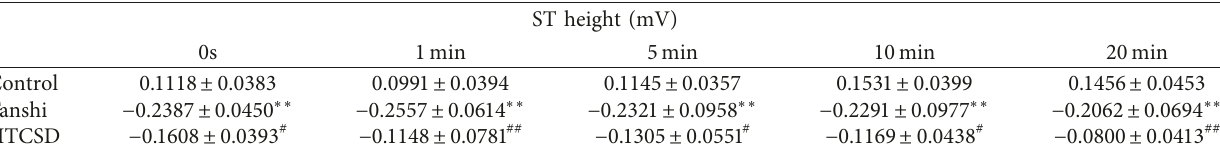
Figure 1: Electrocardiography and echocardiography. (a) ECGs of limb lead II of mice were recorded to evaluate the changes of the ST segment and Twave. (b) LVPW and IVS of mice were measured by echocardiography. Abbreviations: ECG: electrocardiogram, LVPW: left ventricular posterior wall thickness, IVS: interventricular septal thickness, HTCSD: Huo-Tan-Chu-Shi decoction. Table 1: Changes of the ST segment in the ECG of mice (mean ± S .D, n � 5–6).